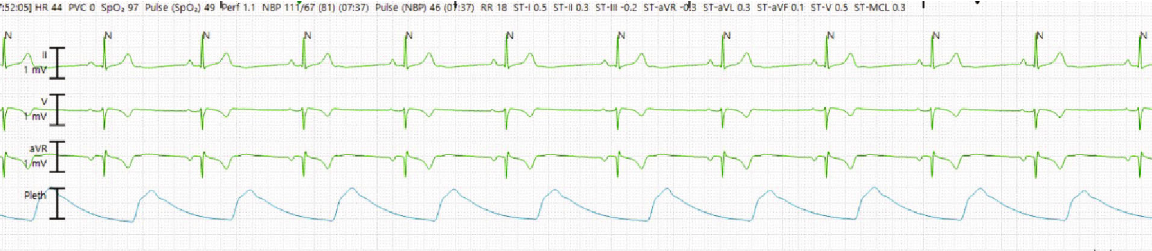
Figure 2: Telemetry strips showing bradycardia after the initiation of RDV (day